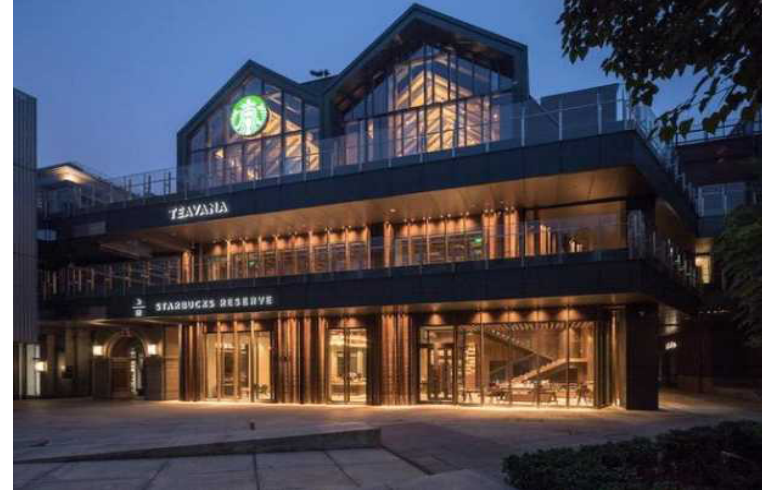
Figure 16. Starbucks Beijing flagship store [67].